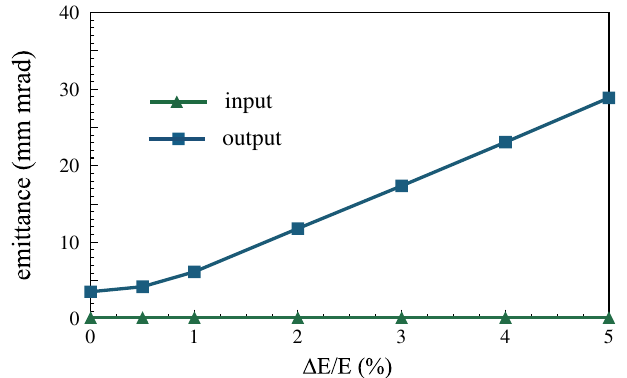
FIG. 9. Emittances for variable (cid:2) E=E ( (cid:1) ¼ 43 mrad